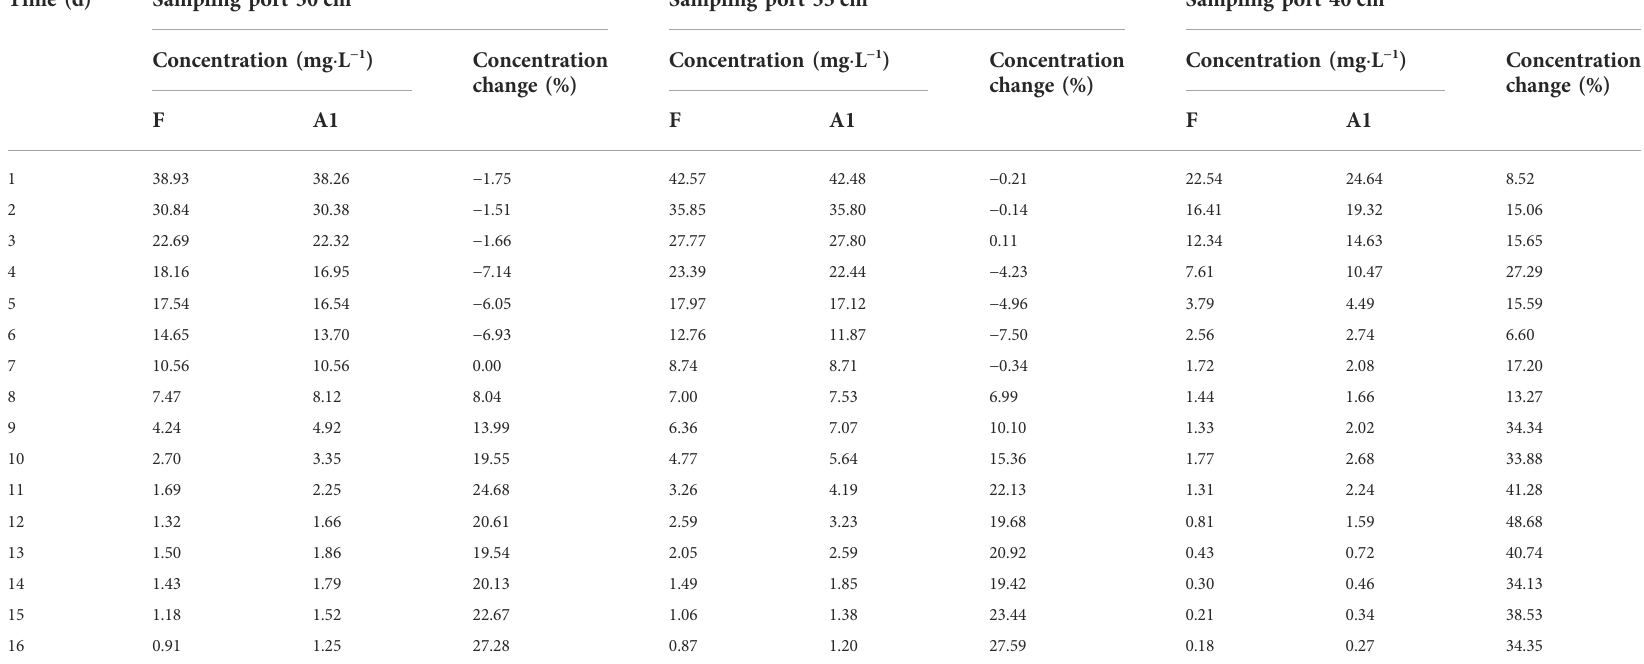
TABLE 5 Scenario 1: comparison of Pb concentration in the sampling water of the coarse sand